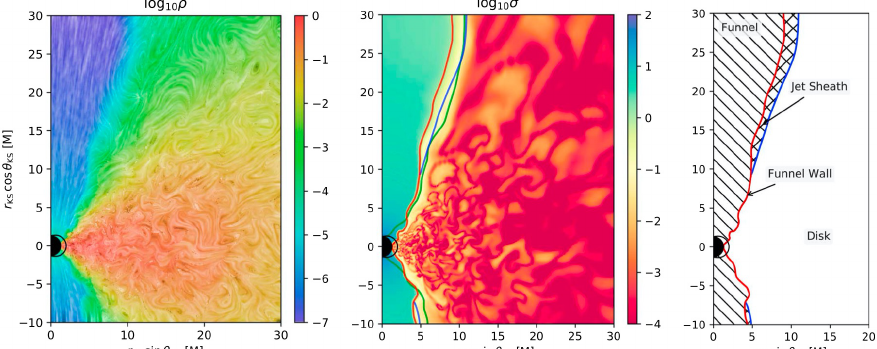
Figure 3. Snapshot of GRMHD simulations of geometrically a thick torus in the SANE regime. Left: color contour shows logarithmic density and white lines indicate rendering of the magnetic field structure using line-integral convolution. Center: color contour shows logarithmic magnetization. The magnetized funnel is represented by σ = 1 (red lines), the disk is indicated by β = 1 (green lines), and the geometric Bernoulli criterion ( u t = − 1) is given by the blue solid line in the region outside of the funnel. Right: schematic of the main components of SANE regime. Figure is reproduced with permission from Porth et al. ApJS, 243, 26 (2019)